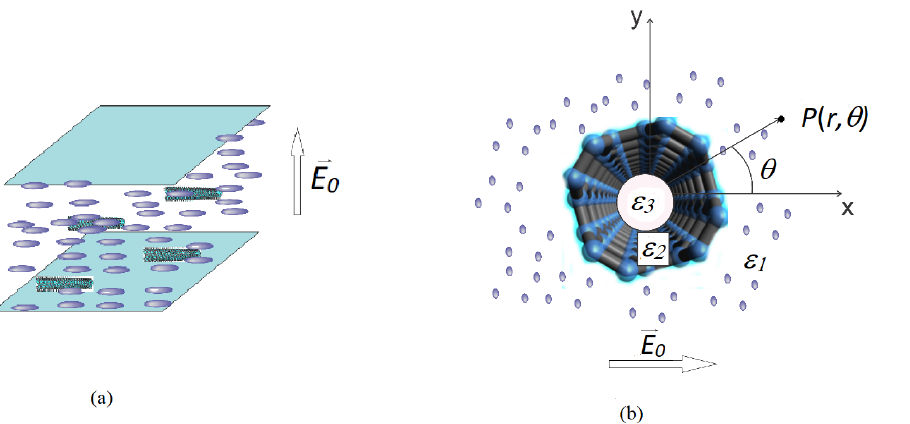
Figure 1. Planar cell containing LC+MWCNT composite: ( a ) the whole cell view, ( b ) inside view .